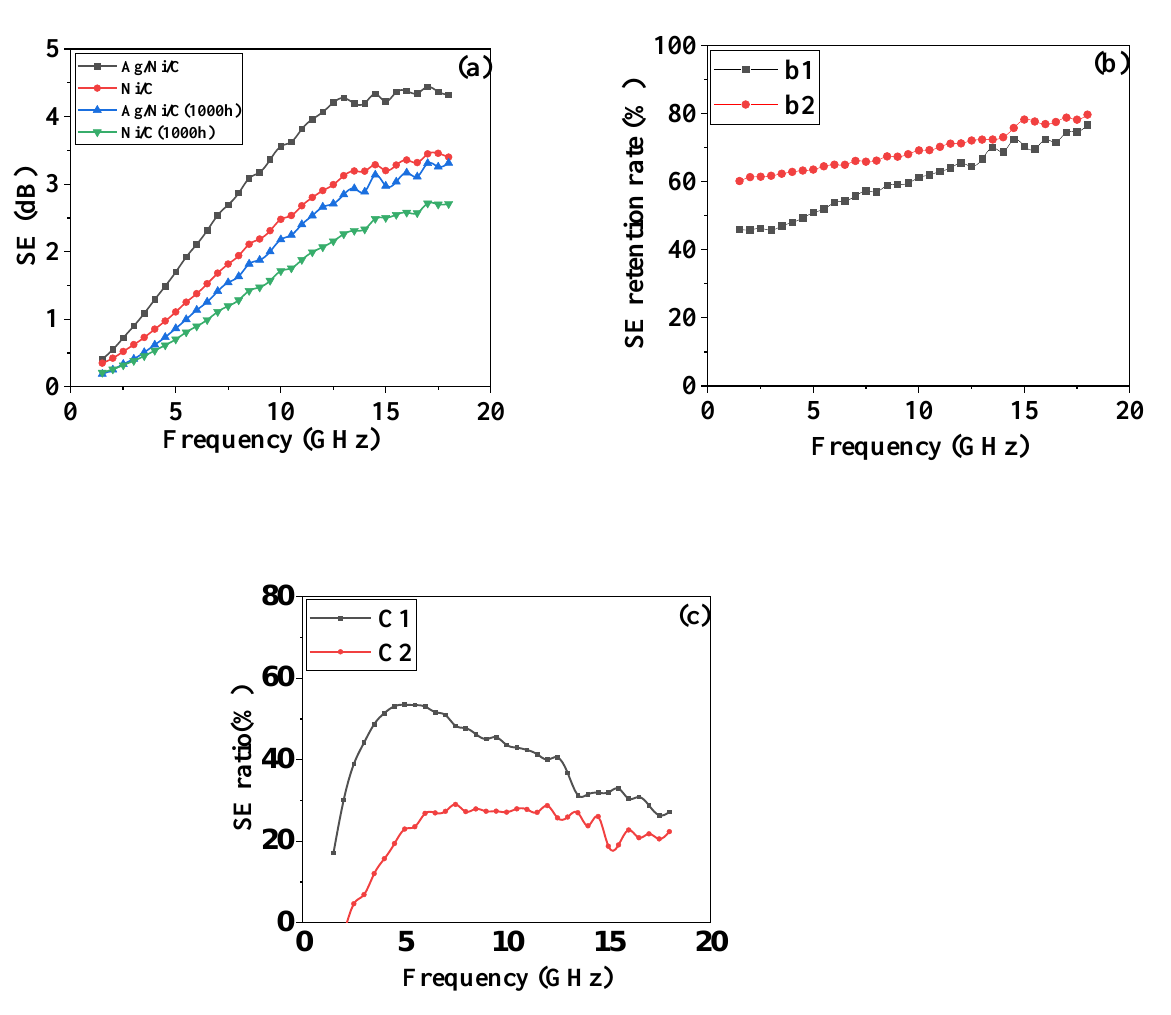
Figure 10. Shielding effectiveness tests of Ag/Ni/C and Ni/C powder-based specimens: ( a ) Shielding effectiveness of four powder materials (Ni/C powders pre- and post-HMT for 1000 h, Ag/Ni/C powders pre- and post-HMT for 1000 h); ( b ) SE retention rate of Ag/Ni/C post- and pre-aging (b1), SE retention rate of Ag/Ni/C post- and pre-aging (b2); ( c ) SE ratios of Ni/C powder to Ag/Ni/C powder pre-aging (c1) and post-aging (c2).